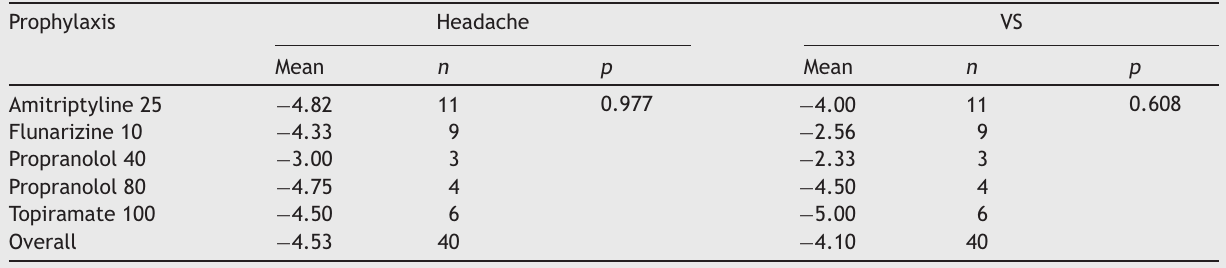
Therapeutic response appraised by the mean variation of VAS after prophylactic treatment in patients with VM per drug used.